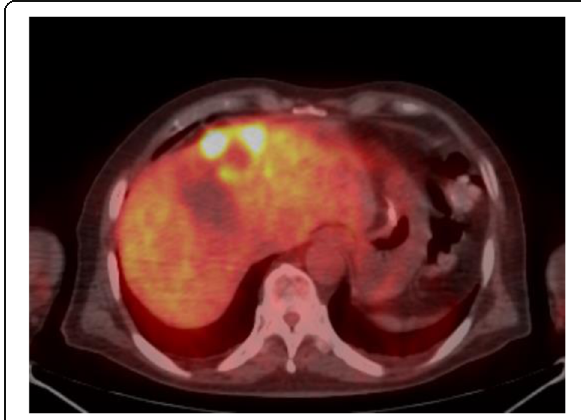
Fig. 4 18F ‑ fluorodeoxyglucose positron-emission tomography findings. The S3+4 tumor verge represented high FDG accumulation